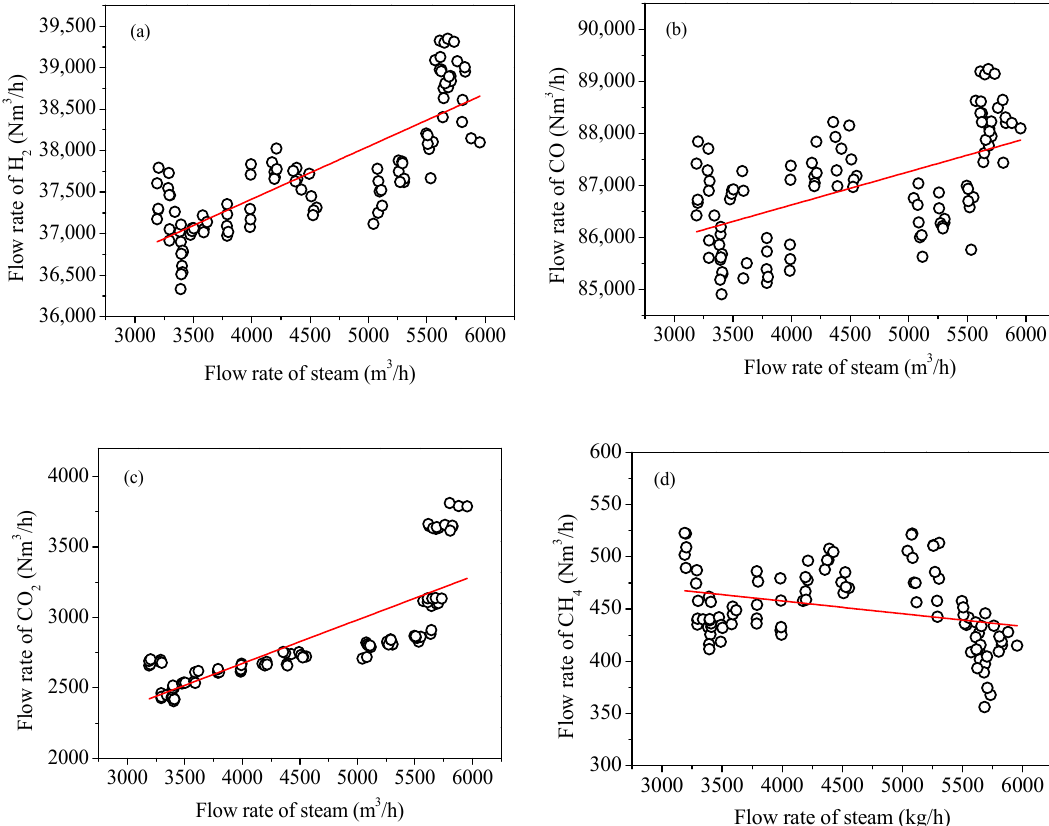
Figure 3. Variations of syngas production with steam flow rate: ( a ) H 2 ; ( b ) CO; ( c ) CO 2 ; ( d) CH 4 . Table 5. The change of syngas production with change of steam flow rate in the combustor. Material